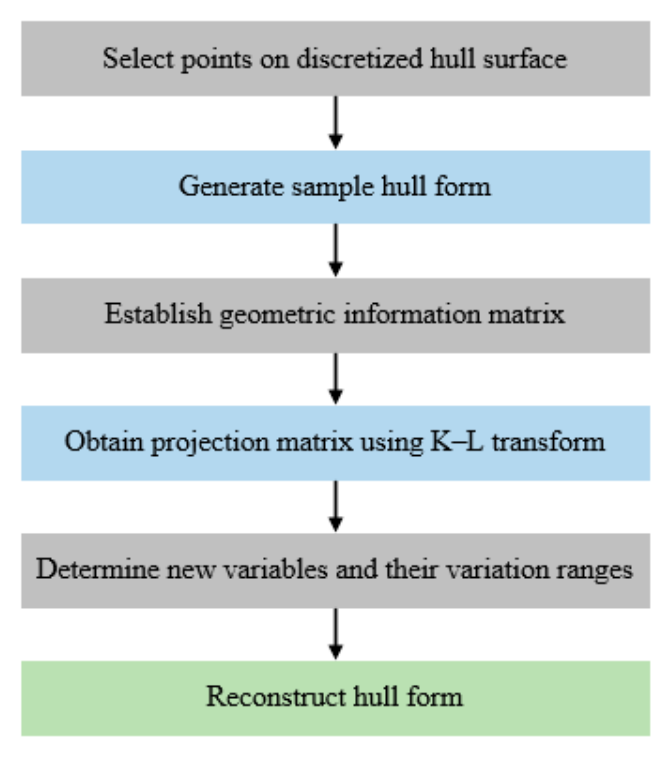
Figure 2. Flowchart of hull form reconstruction.